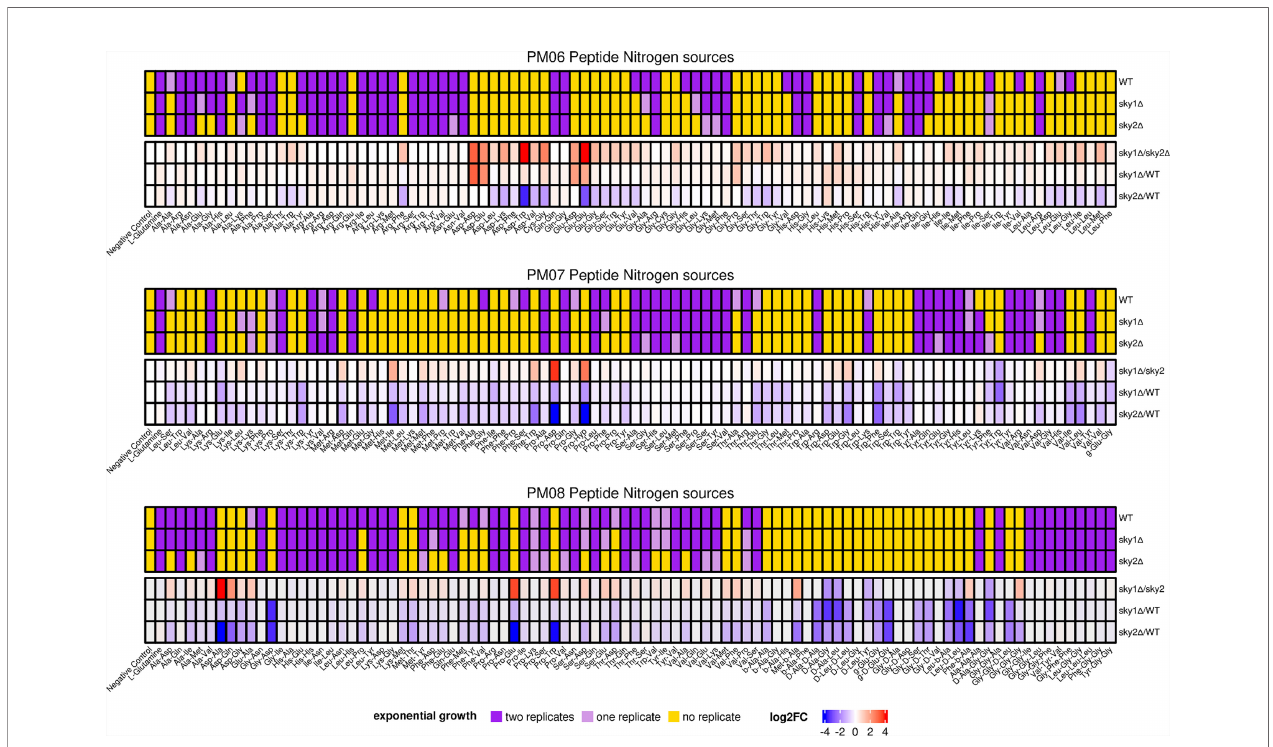
FIGURE 3 | C. albicans Sky2 is required for growth on various dipeptides as the sole nitrogen source. The metabolic activities of the C. albicans SC5314 wild-type strain, Ca sky1 D and Ca sky2 D mutant strains A were measured kinetically every 15 min for 24 h at 30°C by utilizing Biolog ™ phenotypic microarray plates for fungi. Upper panel: exponential growth phase according to the fi tted logistic function in two, one or no replicate given for each tested nitrogen source. Lower panel: End point concentrations at 24 h were used to compute log 2 (fold changes). In the absence of an exponential growth characteristic in the investigated time frame, different end point concentrations and thus log 2 (fold changes) are due to different linear growth activities between the investigated